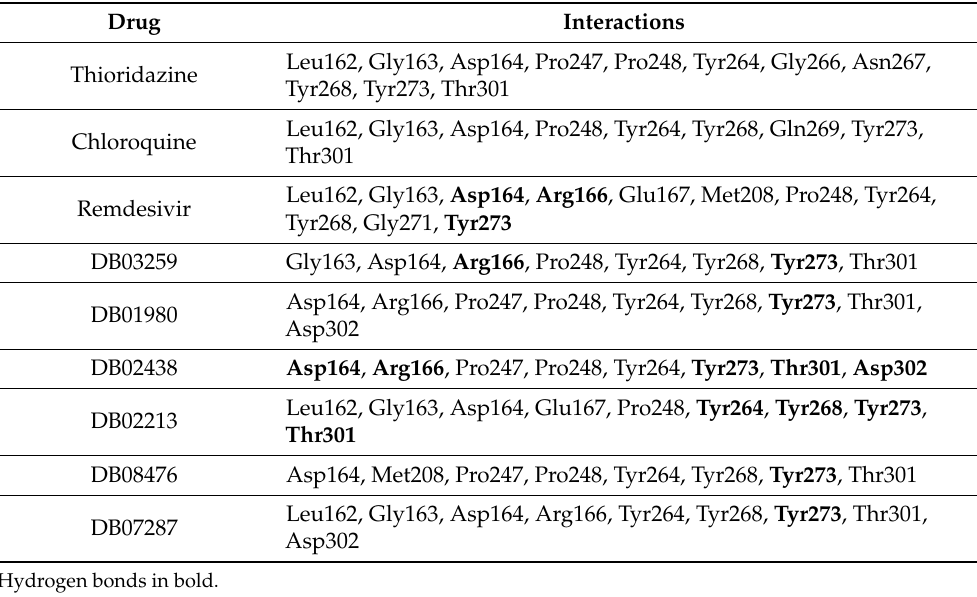
Table 5. Interactions of different drugs with PLpro. Table 5. Cont . Drug Interactions